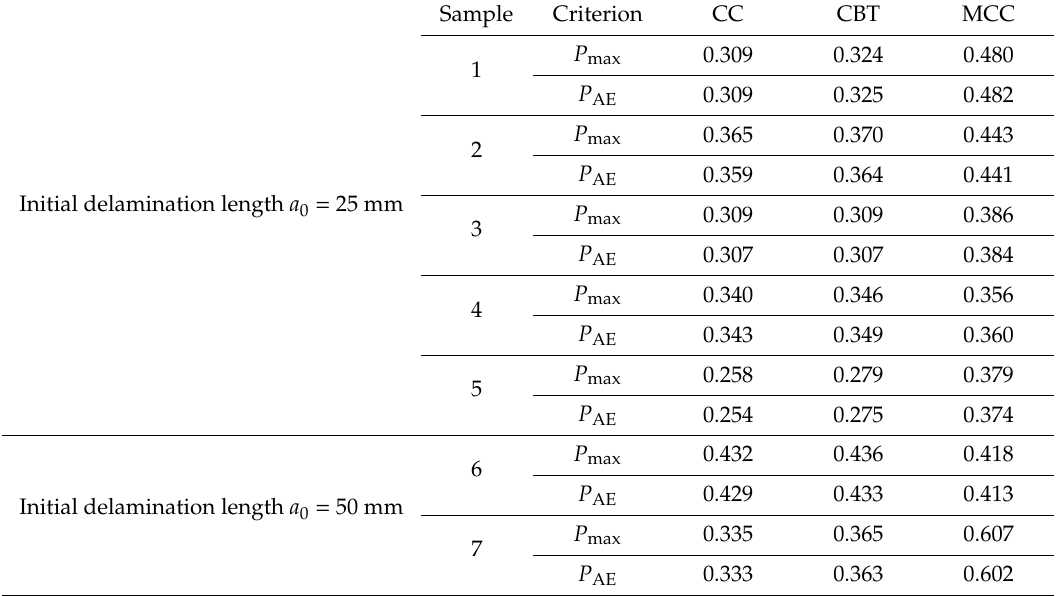
Table 2. Mode I critical strain energy release rates G IC (N /